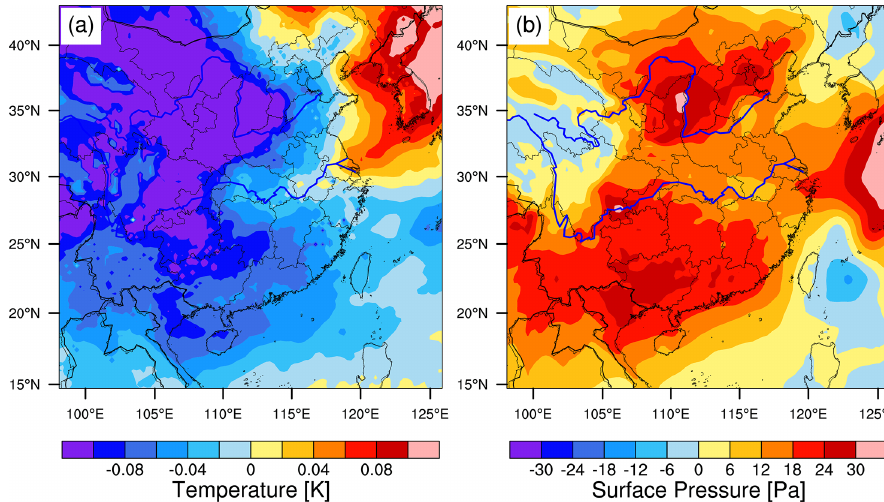
Figure 13. Same as Fig. 9, but from the large-domain simulation.